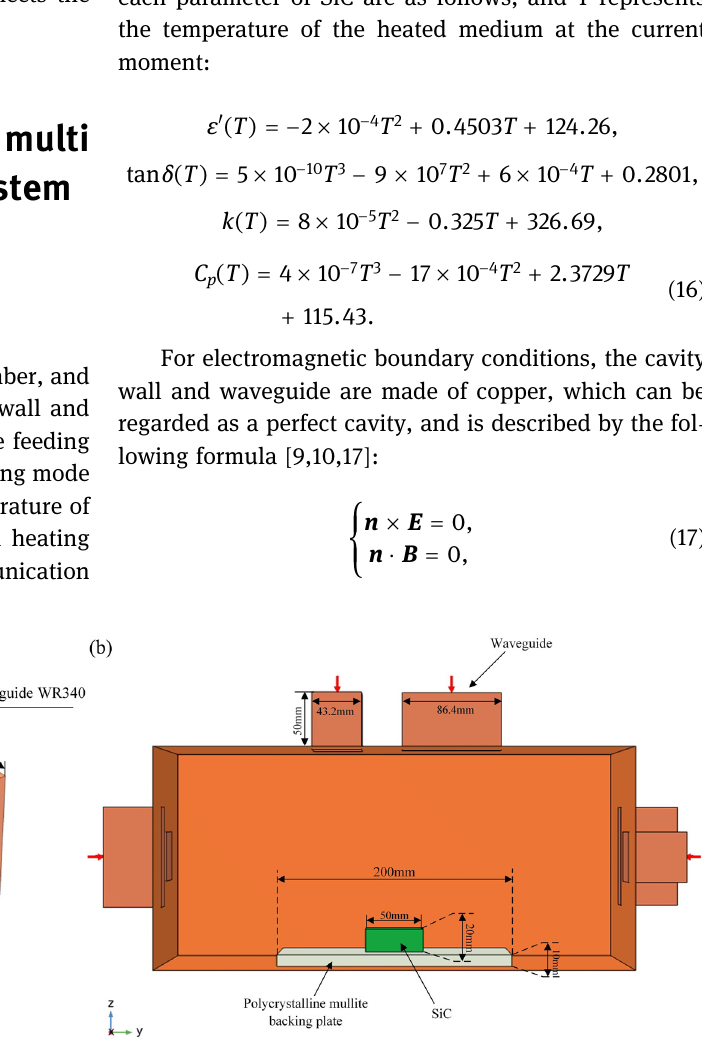
Figure 1: ( a ) Geometric model of the multisource distributed 3D cavity and ( b ) geometry of the y – z cross section.